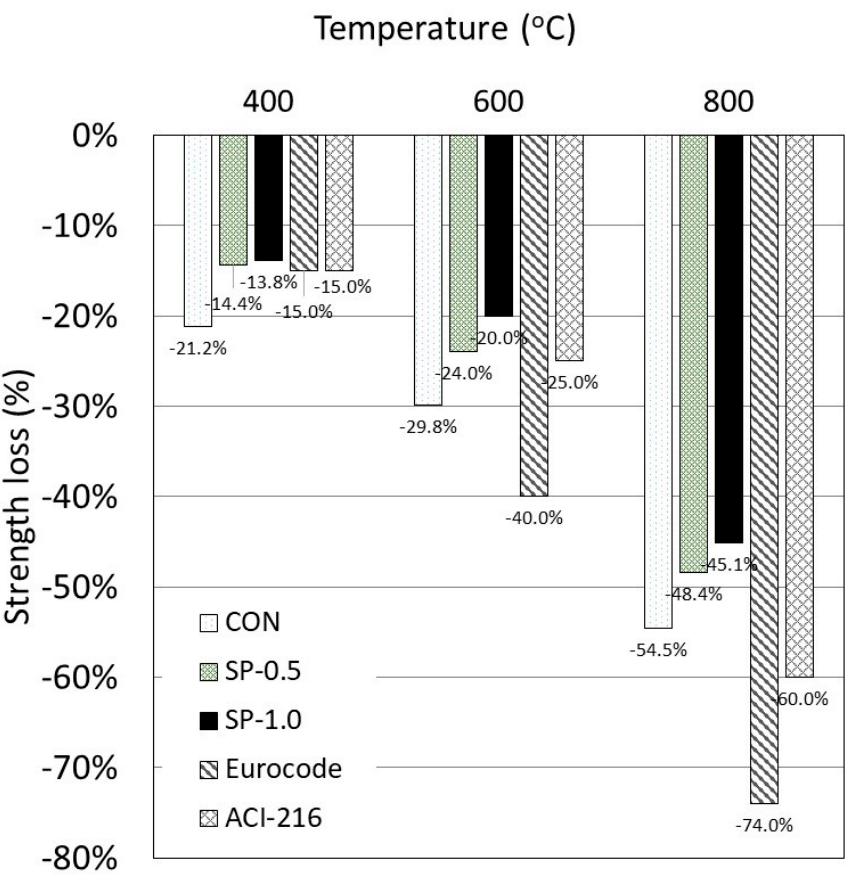
Figure 7. Percentage compressive strength loss of specimens after being exposed to heat.